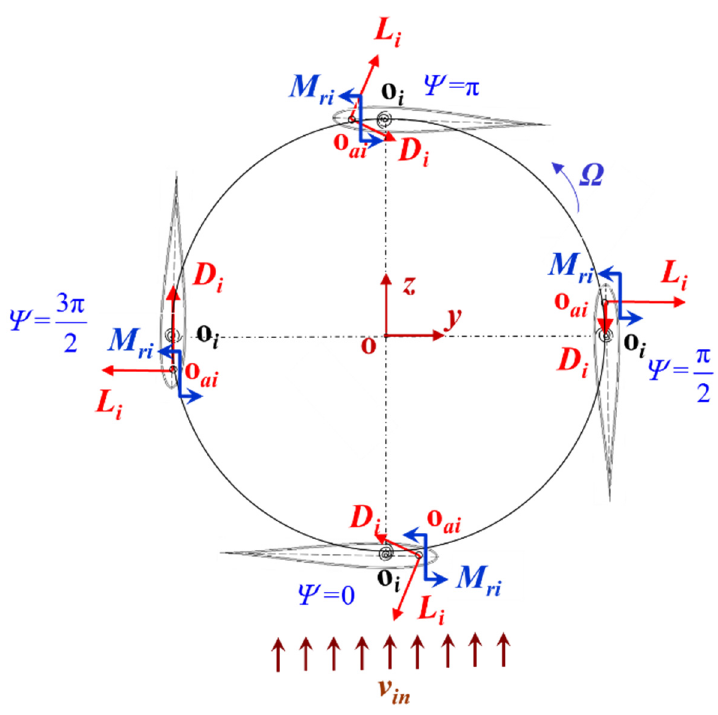
Figure 3. Aerodynamic loads acting on an airfoil section in a revolution.